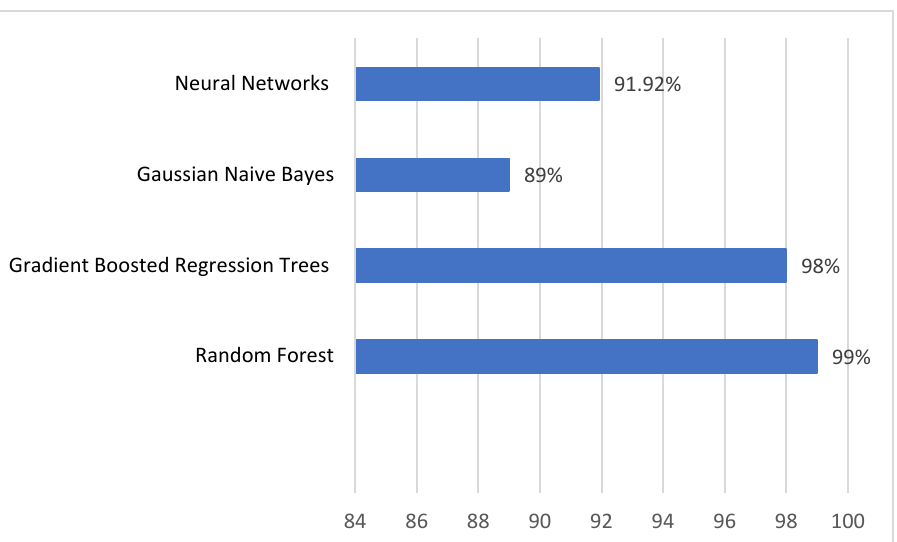
Figure 6. Ten-fold cross-validation accuracy results obtained in step 1.